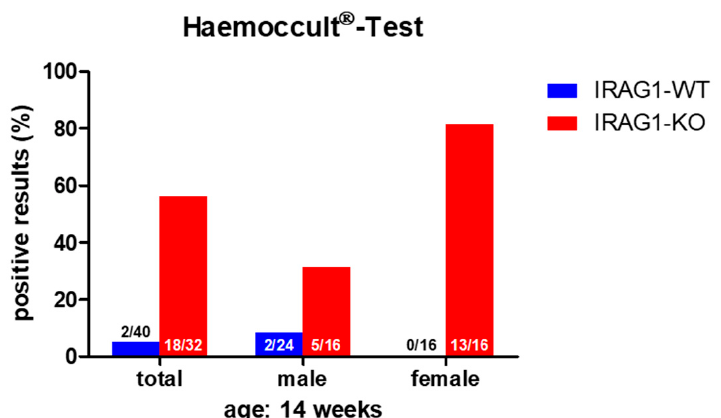
Figure 1. The Haemoccult ® Test of IRAG1-WT and IRAG1-KO mice. Occult blood was found in the IRAG1-KO mice, but with a difference in positive results between male and female IRAG1-KO mice. The numbers in the graphs indicated the mice that had a positive Haemoccult ® Test compared to the total number of investigated mice; “total” indicates the evaluation of both sexes (male and female) from each